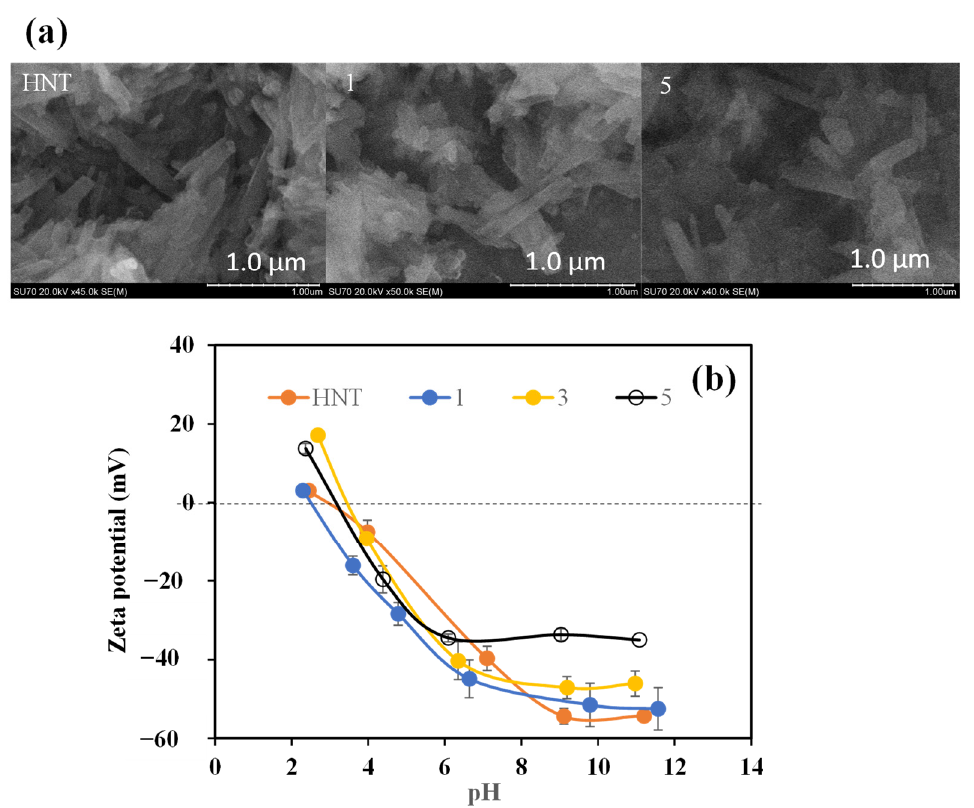
Figure 3. ( a ) SEM images of HNT, PDOPA1@HNT and PDOPA5@HNT clays, and ( b ) zeta potential values for HNT, PDOPA1@HNT, PDOPA3@HNT, PDOPA5@HNT at different pH values (scale bar 1.00 µm in the SEM images).